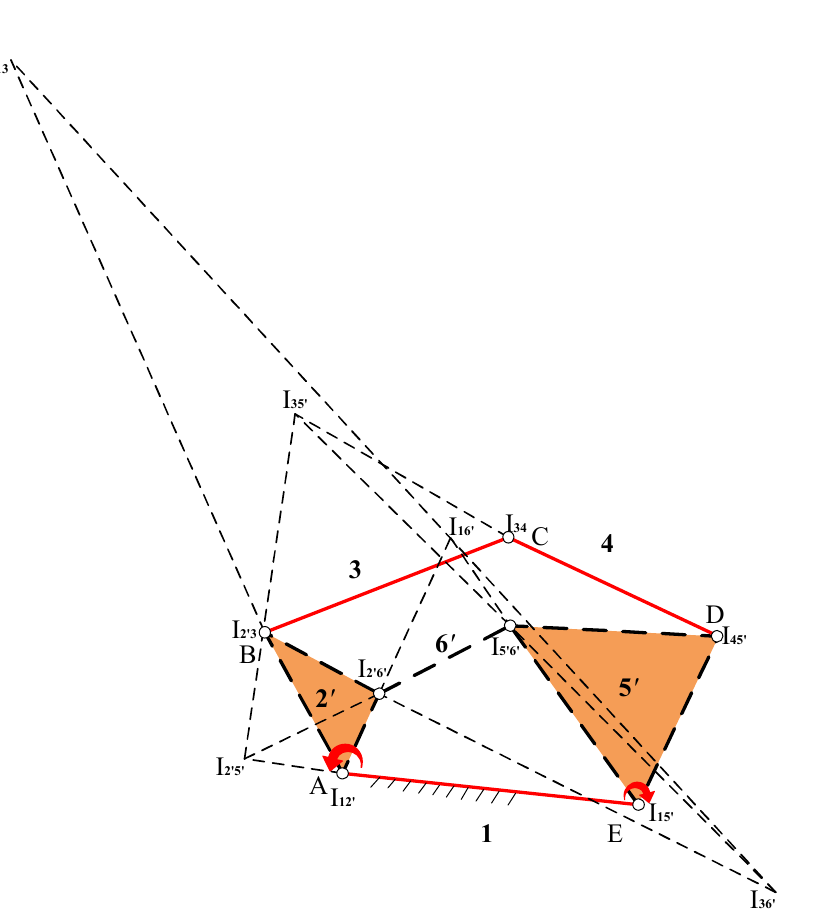
Figure 9. Single-loop five-bar planar linkage with virtual links. I 13